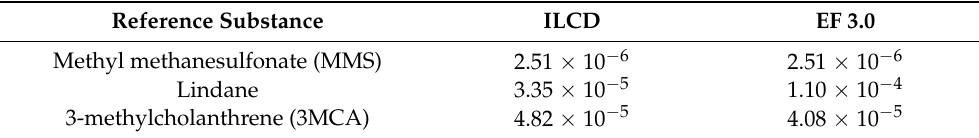
Table 2. Characterization factors for human toxicity/non-cancer reference substances. The ILCD package represents old CFs, whereas the EF 3.0 package represents new